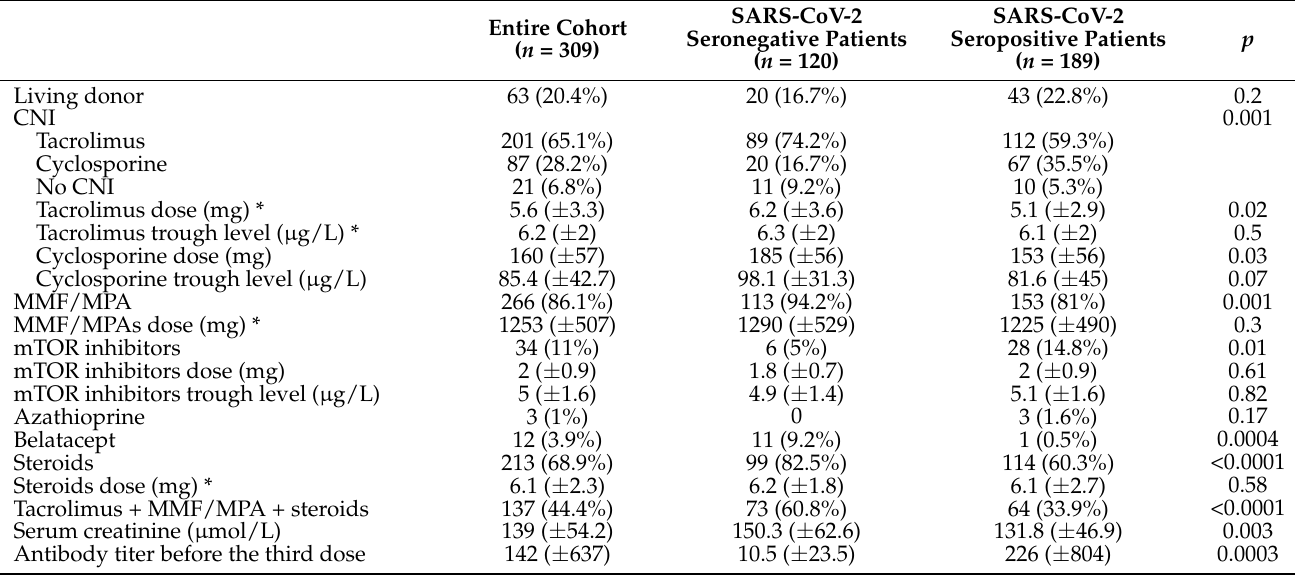
Data are expressed as means ( ± standard deviations) or counts (percentages), as appropriate. Abbreviations: BMI, body mass index; CNI, calcineurin inhibitors; MMF, mycophenolate mofetil; MPA, mycophenolic acid; mTOR, mammalian target of rapamycin. * Missing data for one patient.